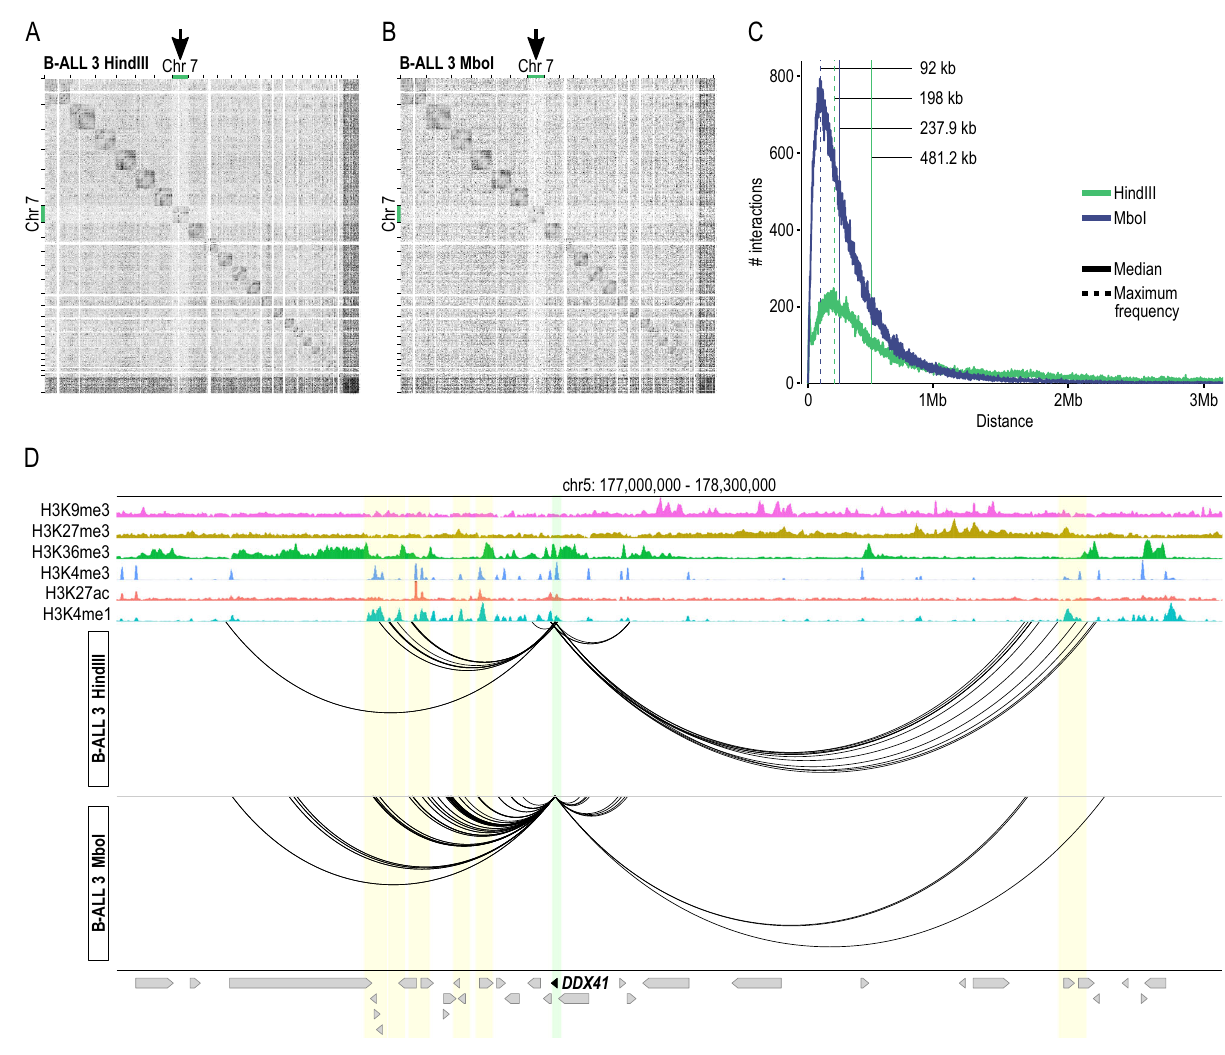
Fig. 7 | Comparison of liCHi-C libraries at different resolutions. Detection of structural variants using liCHi-C data for B-cell precursor acute lymphoblastic leukemia(B-ALL)sample3generatedusingasix-cutterrestrictionenzyme(HindIII) ( A ) and a four-cutter restriction enzyme (MboI) ( B ). Gray matrices represent the ratio between B-ALL and CLP contact matrices at 1Mb resolution across the gen- ome. Black arrows indicate the location of copy number losses. C Absolute fre- quency of interaction according to the genomic distance between interacting